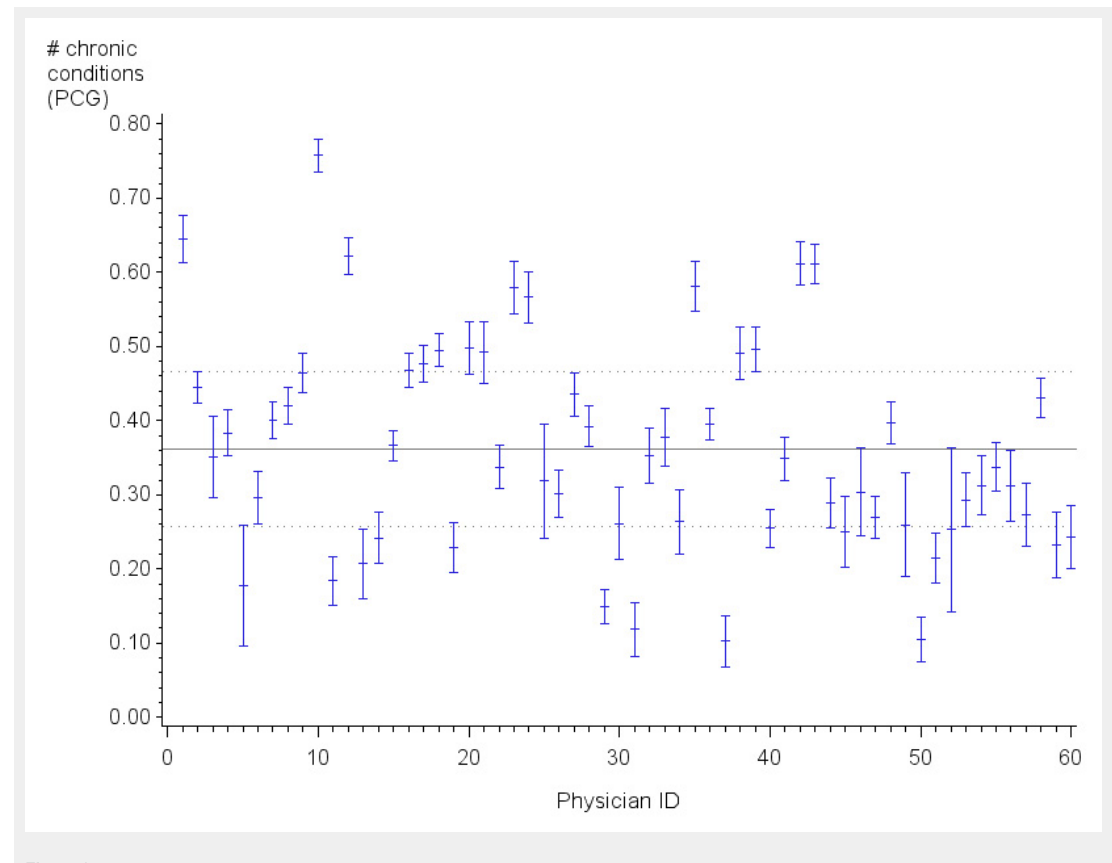
Figure 2 Variation of average number of PCG based chronic conditions per patient across 60 primary care practices. a The horizontal line denotes the overall averages of PCG at the practice level, dotted lines the first and third quartile. Error bars show the 95% confidence interval of PCG based morbidity estimates of